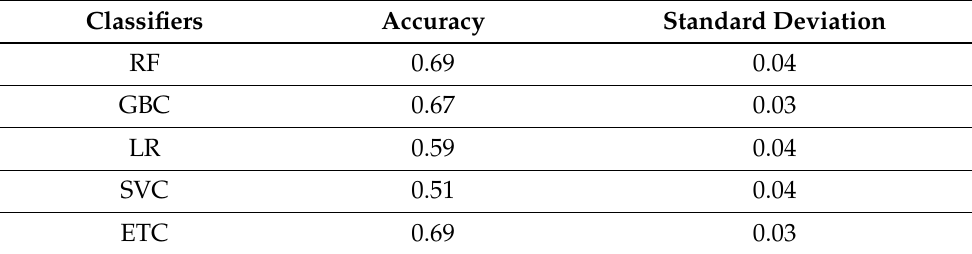
Table 14. K-fold cross-validation results on the original dataset using machine learning